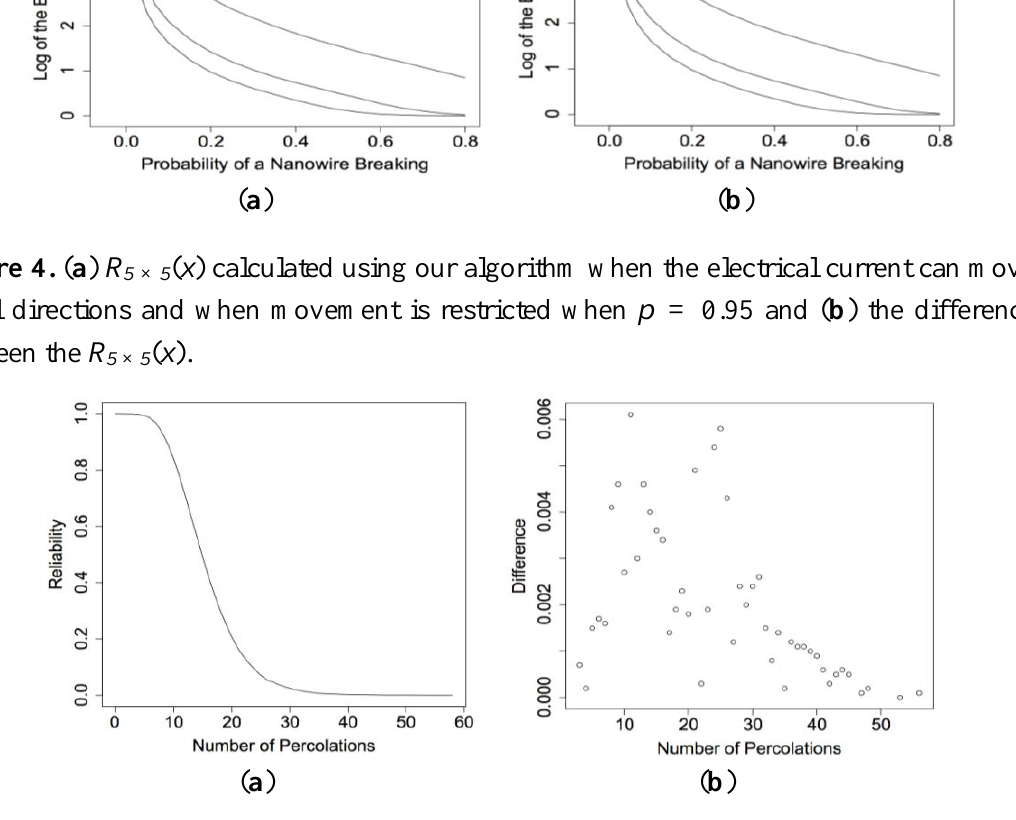
Figure 5. log E ( X E ) calculated using our algorithm for various values of n and m when n × m ( a ) the electrical current can move in all directions and when ( b ) movement is